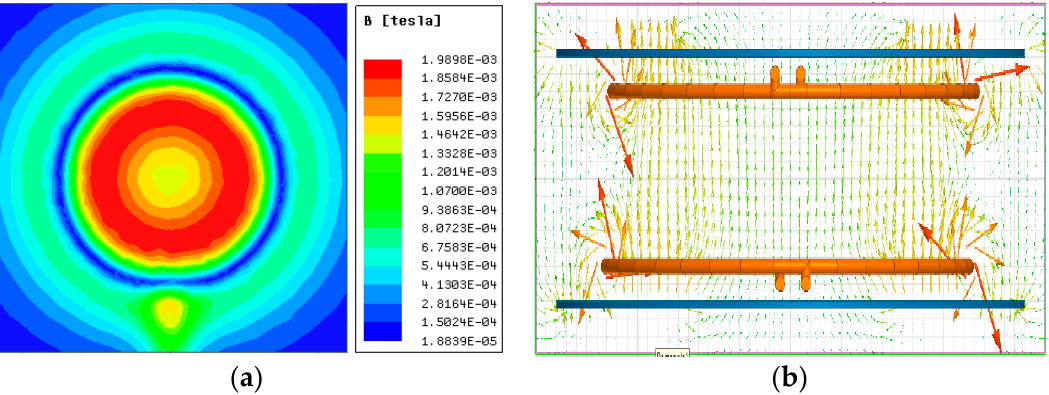
Figure 11. Magnitude plot ( a ) and vector plot ( b ) of the B field between Tx and Rx of the CP–CP configuration.